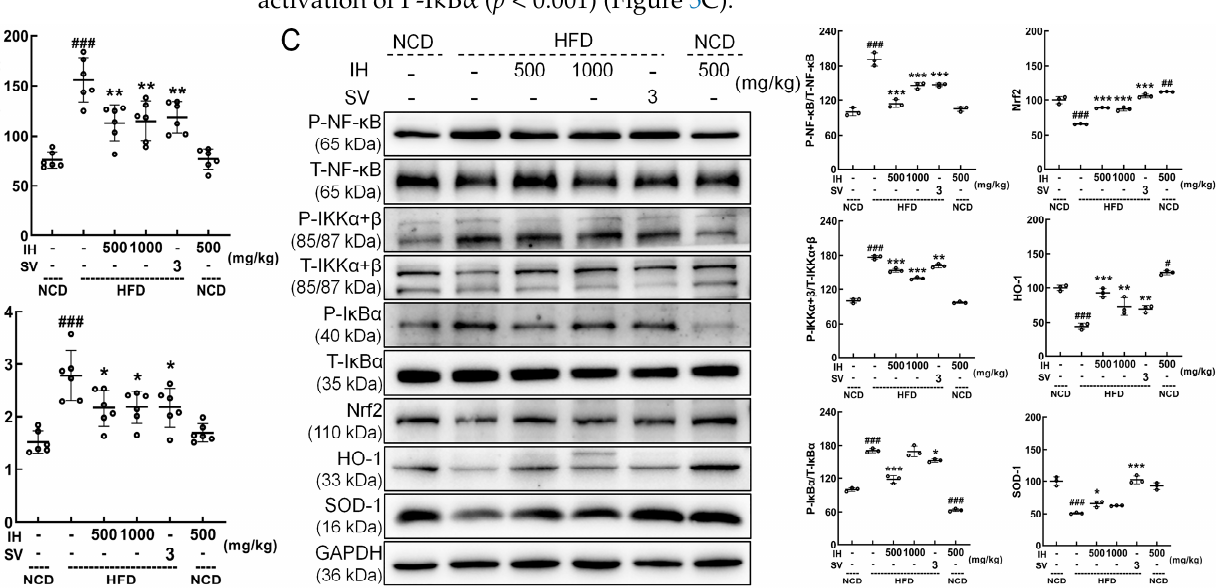
Figure 5. IH had significant antioxidant activities. Compared with vehicle-treated HFD-fed mice, IH decreased the levels of ( A ) ROS and ( B ) MDA in the liver. ( C ) IH influenced the Nrf2/NF- κ B pathway in the livers of HFD-fed mice. IH administration decreased the phosphorylation levels of NF- κ B, IKK α + β , and I κ B α and increased the levels of Nrf2, HO-1, and SOD-1 in the livers of HFD-fed mice. Quantification data were normalized to GAPDH or the corresponding total protein concentration and expressed as the percentage of vehicle-treated NCD-fed mice. Data were analyzed using a one-way ANOVA and expressed as the means ± SD ( n = 3). # p < 0.05, ## p < 0.01, and ### p < 0.001 versus vehicle-treated NCD-fed mice; * p < 0.05, ** p < 0.01, and *** p < 0.001 versus vehicle-treated HFD-fed